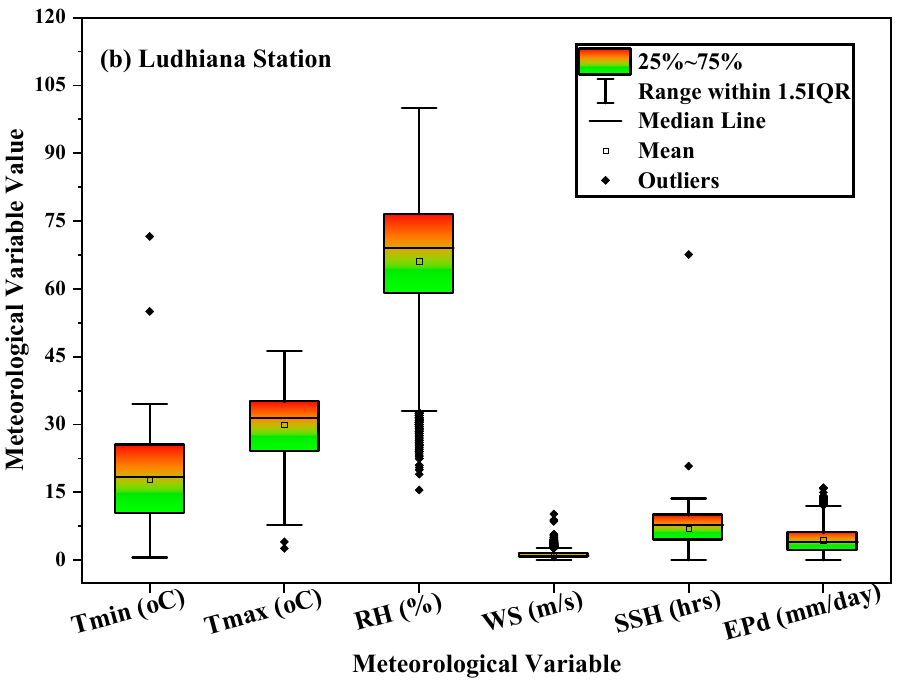
Figure 3. Box plot of meteorological variables: ( a ) New Delhi station and ( b ) Ludhiana station.